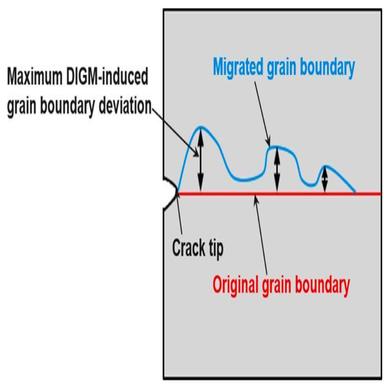
Schematic illustration of DIGM-induced ununiformed deviation from the original GB to the migrated GB.